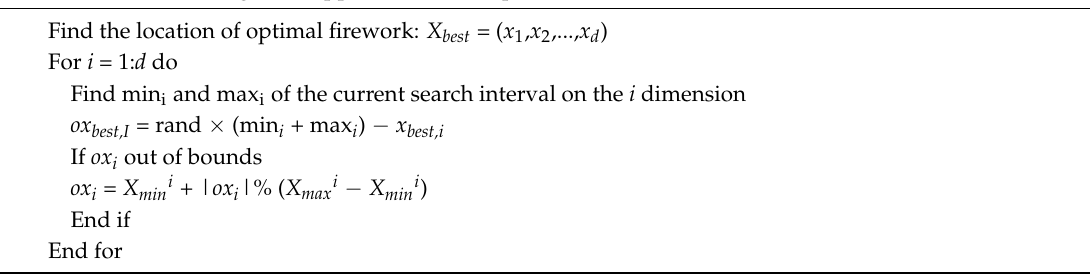
Algorithm 7 is performed for elite opposition-based learning for optimal firework to generate location of sparks. This algorithm is performed N op times ( N op is a constant to control the number of elite opposition-based sparks). Algorithm 7: Generating Elite Opposition-Based